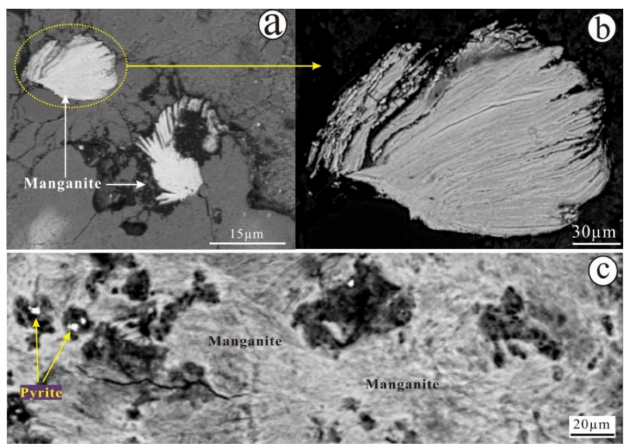
Figure 7. Backscattered electron (BSE) images of the manganite from the Sanbao deposit: ( a ) the exsolution (perthite-like) structure of manganite; ( b ) a larger version of (a); ( c ) relic pyrite associated with massive manganite.